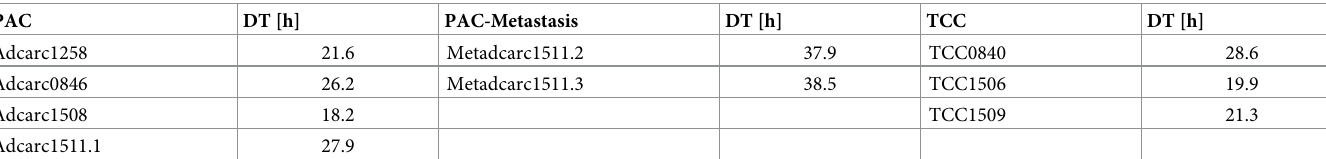
Table 3. Doubling times (DT) of cell lines in